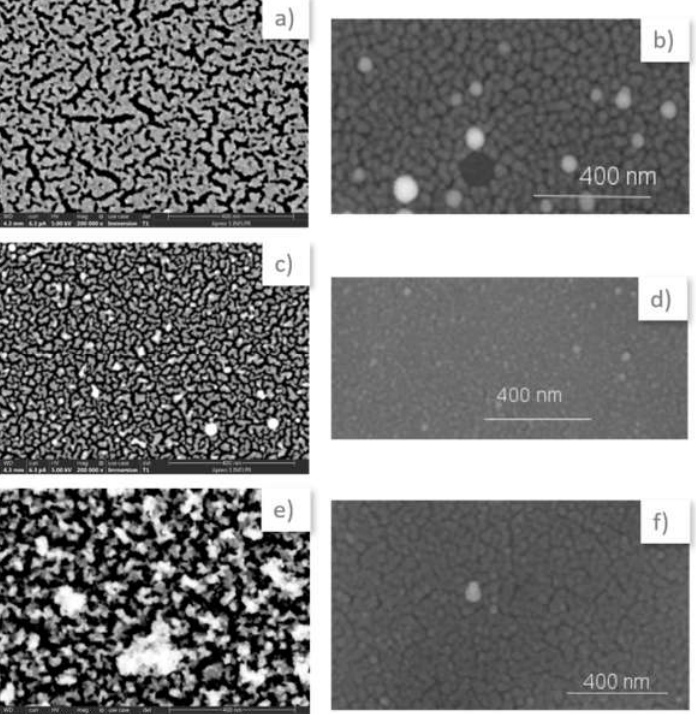
Figure 4. Difference in morphology of Au thin film deposited onto Si surface (left column) and PMMA surface (right column) in the same conditions: ( a , b ) 1 Torr; 10,000 p; ( c , d ) 4 Torr; 30,000 p; ( e , f ) 4 Torr; 30,000 p.